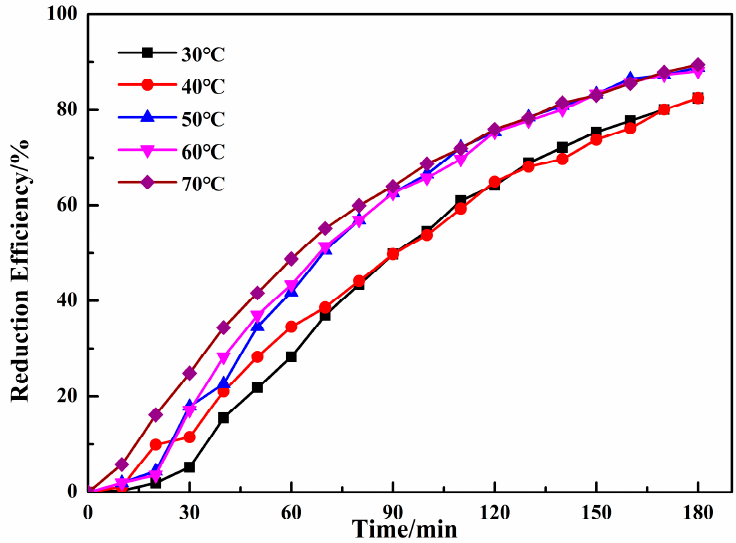
Figure 3. Effect of reaction temperature on the reduction efficiency of chromium (VI).